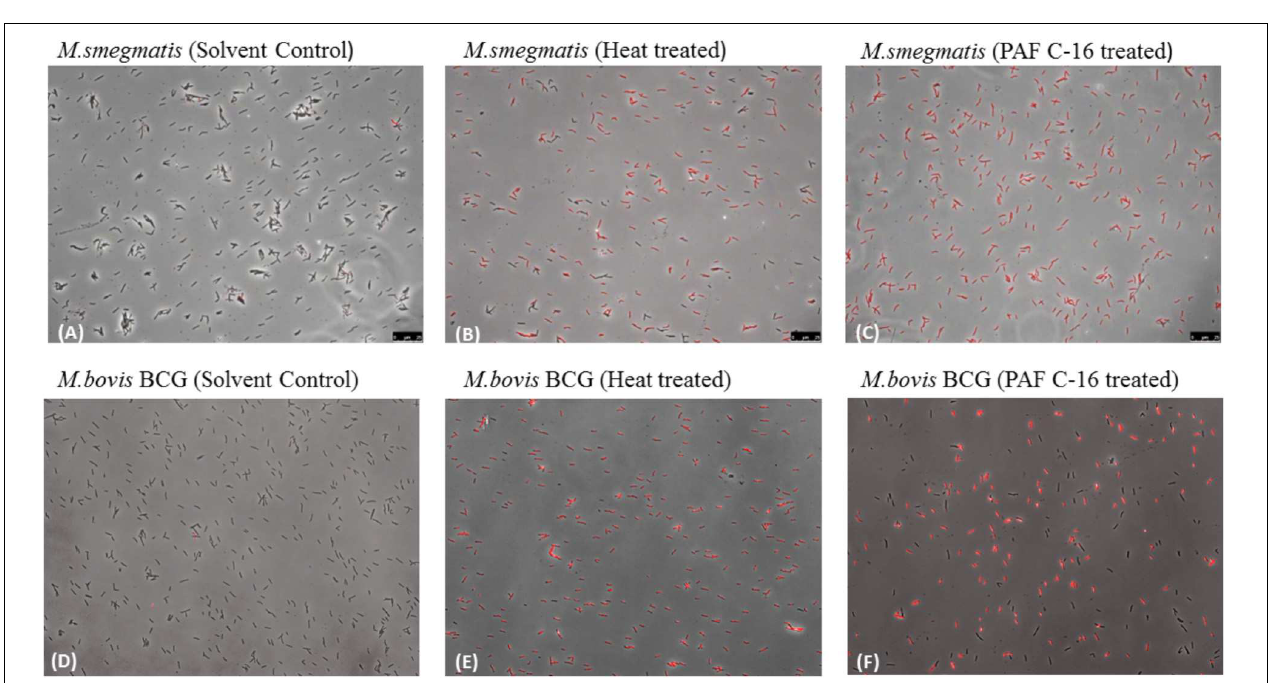
FIGURE 6 | Effect of Palmitic acid, Phosphocholine chloride calcium tetrahydrate, 1-O-hexadecyl- sn -glycerol, Miltefosine, and Hexadecyl lactate on M. smegmatis survival. The data is expressed as percentage where solvent control is taken as 100% survival. Each data point represents the average of three individual experiments performed in triplicate and the error bars show the standard error of mean values ( ± SEM).